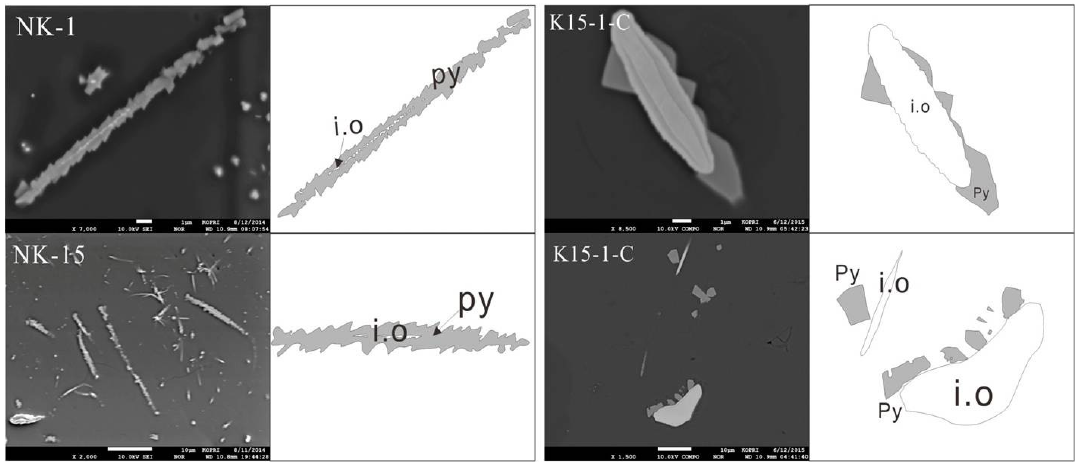
Figure 2. Secondary electron microscope (SEM) images and their sketches of the microlites in the Baekdusan (left) and Kyushu (right) obsidians. Hair-like microlites show poikilitic texture of Fe-oxides and clinopyroxenes in the Baekdusan obsidians, whereas clinopyroxenes occur as overgrowths on or intergrowths with clinopyroxenes in the Kyushu obsidians. Abbreviations: i.o, Fe-oxide; py,